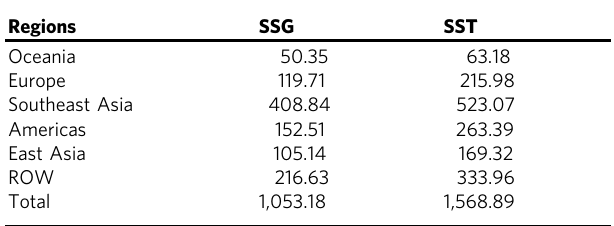
Table 2 Lifetime net carbon emission reduction potential from traded solar cells and modules in importing regions (MtCO 2